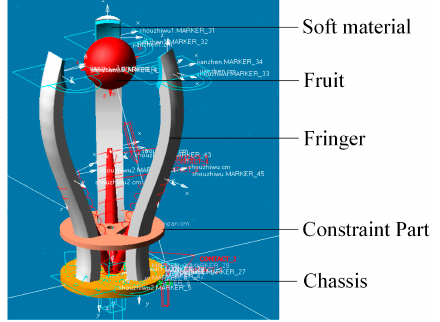
Figure 8. The Adams simulation model of gripper.